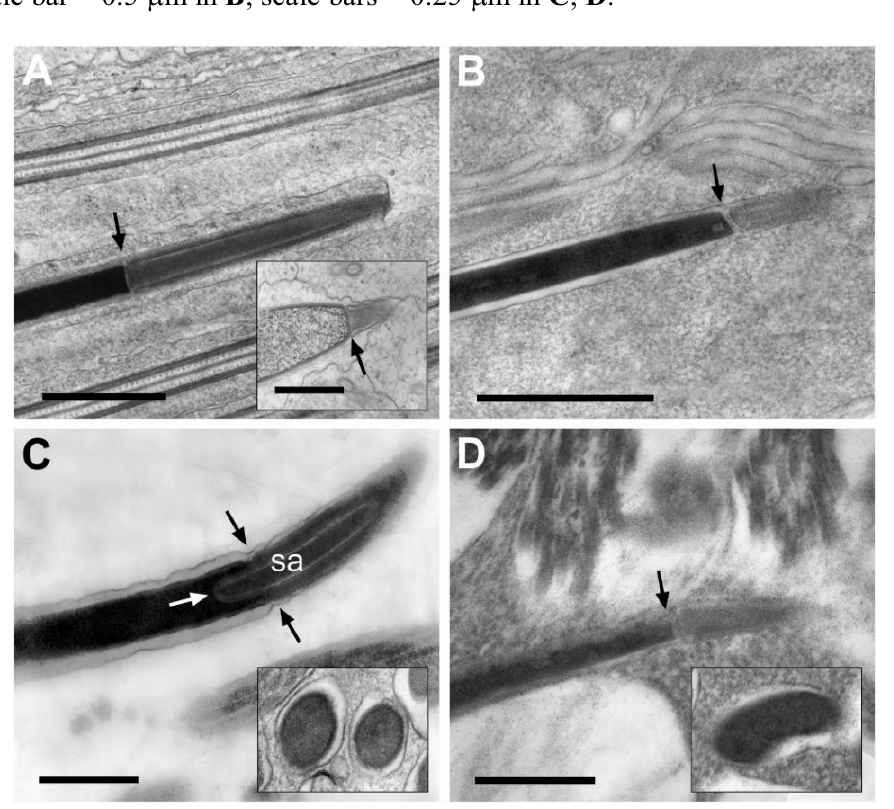
Figure 3. The acrosome forms a straight interface (arrows) with the adjacent nucleus in Meloids and Strepsipteran ( A , B , D ). The rhipiphorid acrosome, by contrast, with its subacrosomal material (sa) forms a curved interface with the nucleus. ( C ) Its interface with the nucleus is marked with three arrows. The acrosome is at right in all figures. ( A ) Hycleus scutellatus . Inset = Mylabris variabilis . ( B ) Zonitis flava. ( C ) Macrosiagon triscuspidata . ( D ) Eoxenos laboulbenei. The insets in C and D show shapes of nuclei in transverse sections for M. triscuspidata and E. laboulbenei, respectively . Scale bars = 1.0 (cid:541) m in A ; scale bar = 0.5 (cid:80) m in B ; scale bars = 0.25 (cid:80) m in C , D